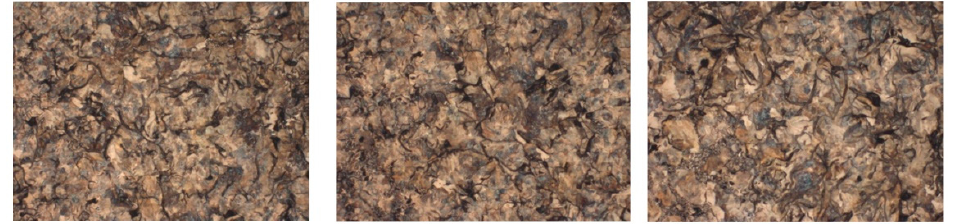
Figure 20. Microstructure of cast iron samples with lamellar graphite type EN-GJL-250, after metallographic attack at 100× magnification.